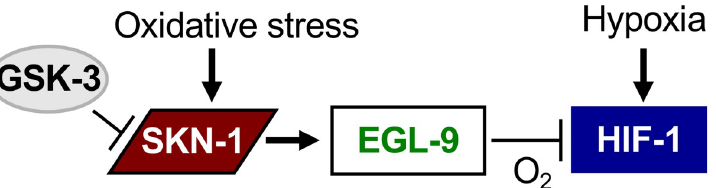
Fig 7. SKN-1 regulates egl-9 expression to attenuate HIF-1. Model illustrating interactions between key regulators of oxygen homeostasis in C . elegans . SKN-1 promotes egl-9 transcription, and EGL-9 controls oxygen-dependent degradation of HIF-1